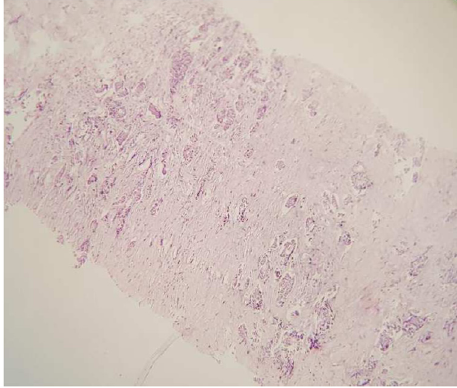
Figure 3. Breast invasive ductal carcinoma, CNB, H and E X100.